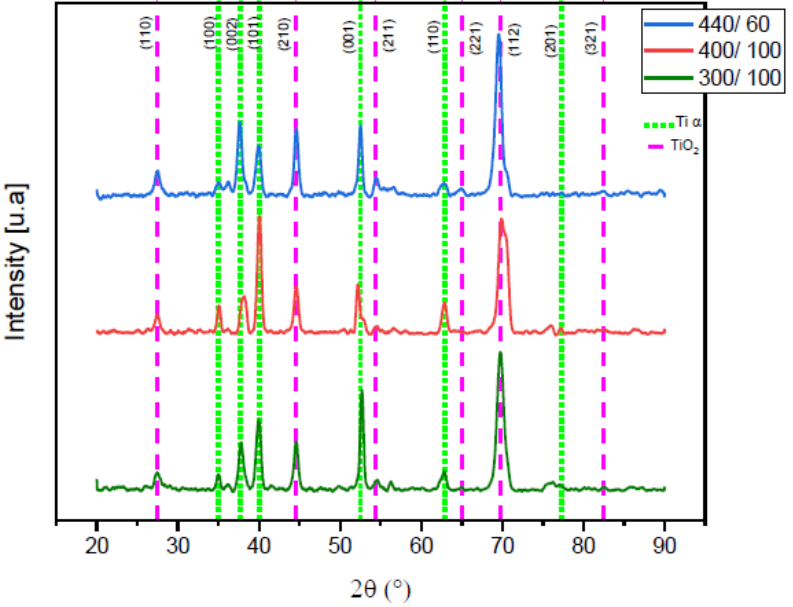
Figure 6. XRD diffractograms of heat-treated arc-PVD TiO x coatings showing the characteristic peaks of hexagonal-Ti and rutile-TiO 2 .